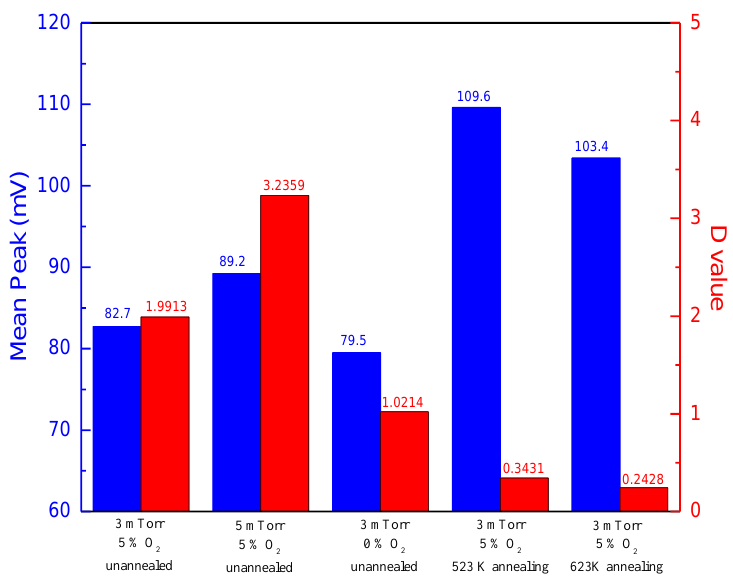
Figure 7. Peak value and D value changes under different conditions. 3.4. Characterization of ZATO TFTs with Different Annealing Temperatures